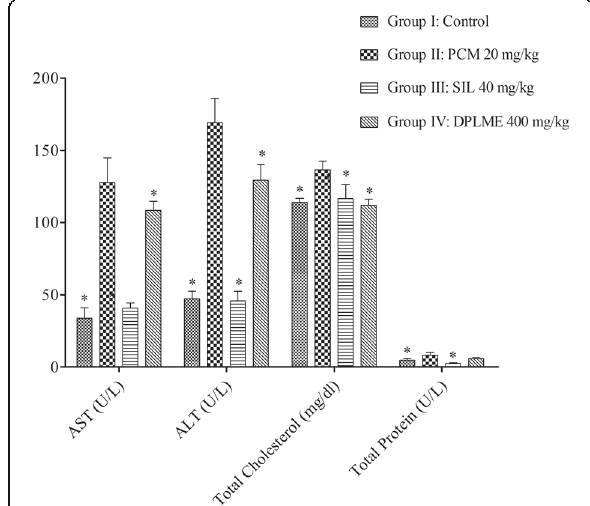
Fig. 3 Effect of pre-treatment with D. pentandra leaf methanolic extract on key liver function parameters in paracetamol-induced hepatotoxicity in Rats. Values are expressed as mean ± SEM (n = 4). * p < 0.05 denotes statistically significant results for a group when it was compared with the PCM group (Group